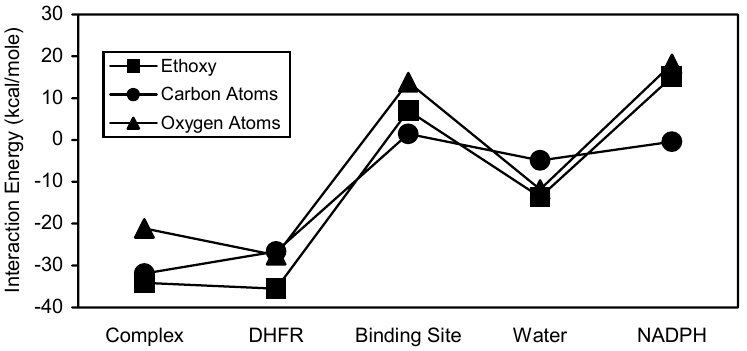
Figure 14. Comparison of interaction energy analysis of the ethoxy region of EPM with its carbon and oxygen atoms.